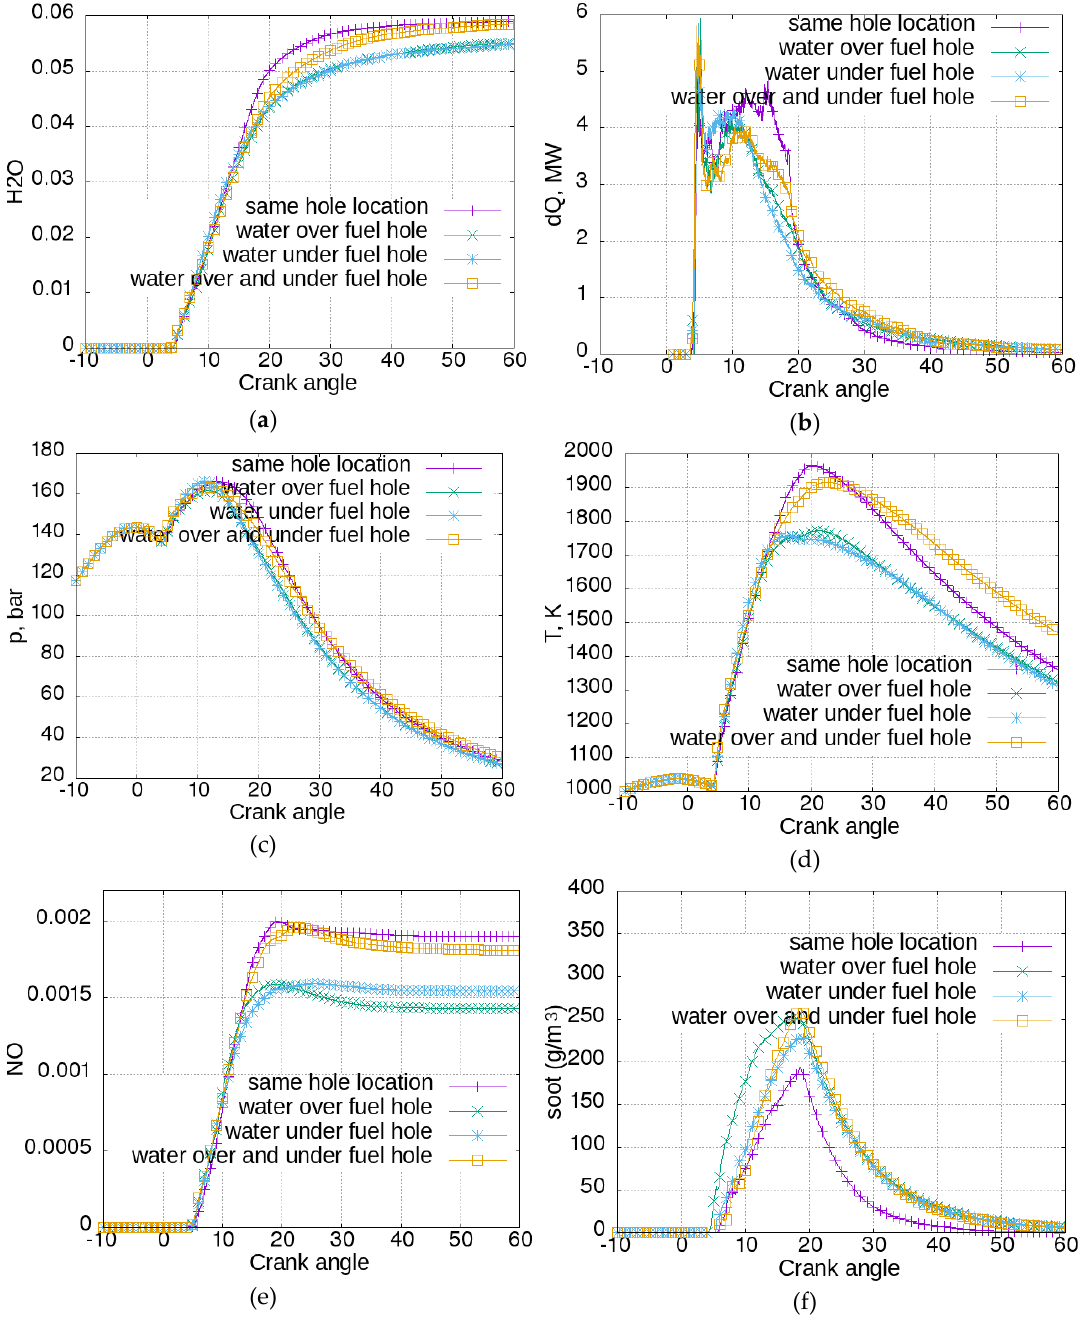
Figure 6. The influence of the location of the water injector on the main combustion parameters: ( a ) Water vapor concentration; ( b ) Rate of heat release; ( c ) Cylinder pressure; ( d ) Cylinder temperature; ( e ) NO concentration; ( f ) Soot concentration.